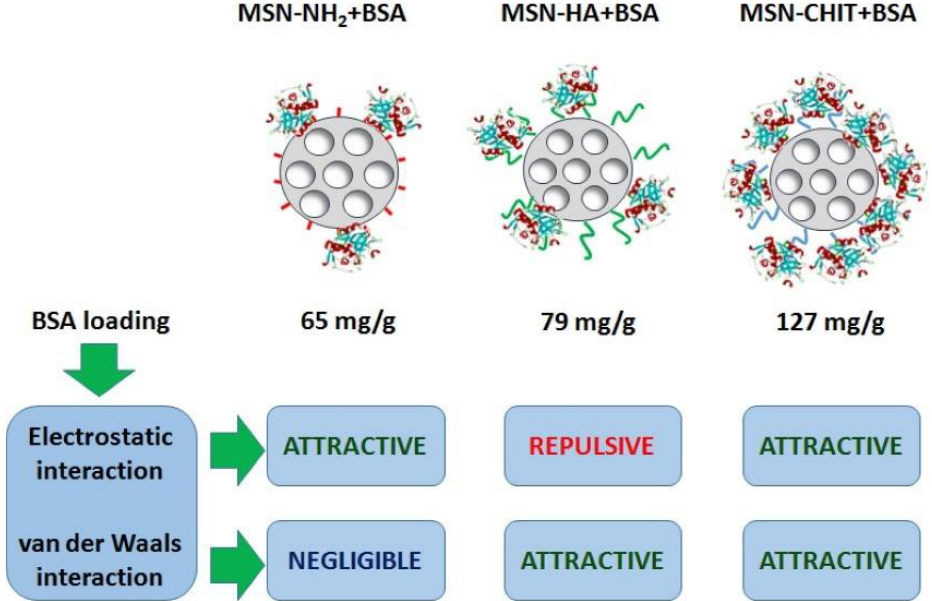
Figure 12. Schematic illustration of the interactions responsible of the formation of the protein corona on functionalized MSNs. Reproduced with permission from ref. [265]. Copyright 2018, Elsevier B.V.